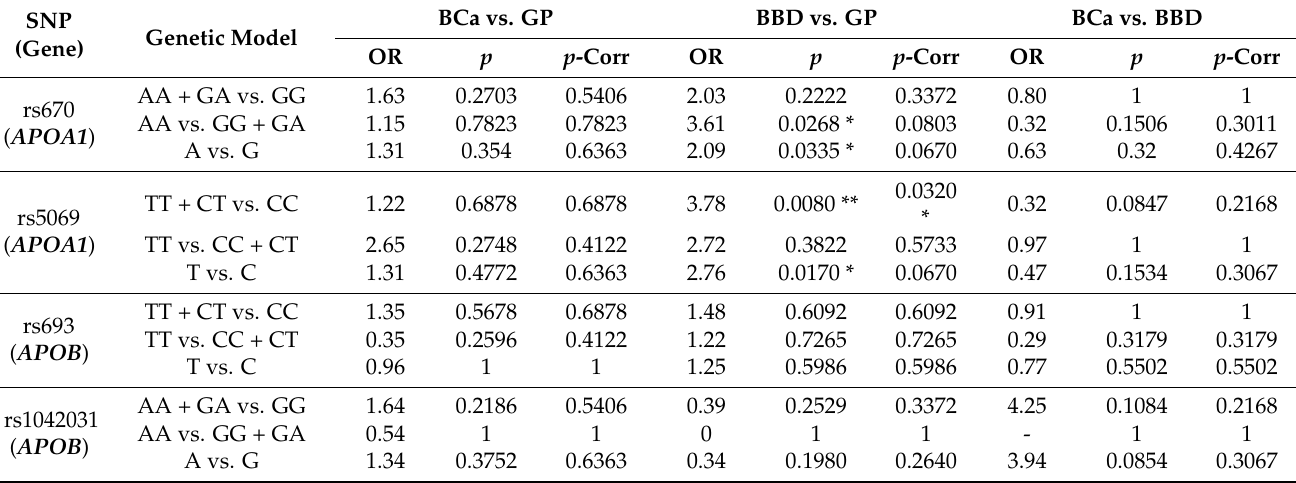
Table 2. rs670, rs5069, rs693 and rs1042031 association analysis under different genetic models for all